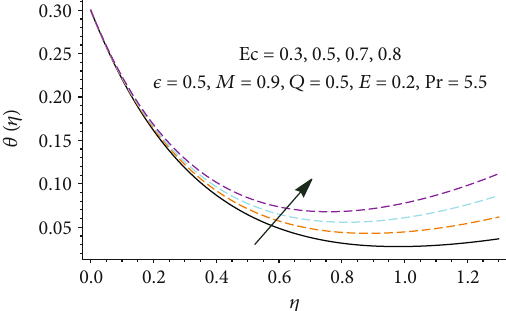
Figure 4: Illustration of the in fl uence of Ec on θ ð η Þ .